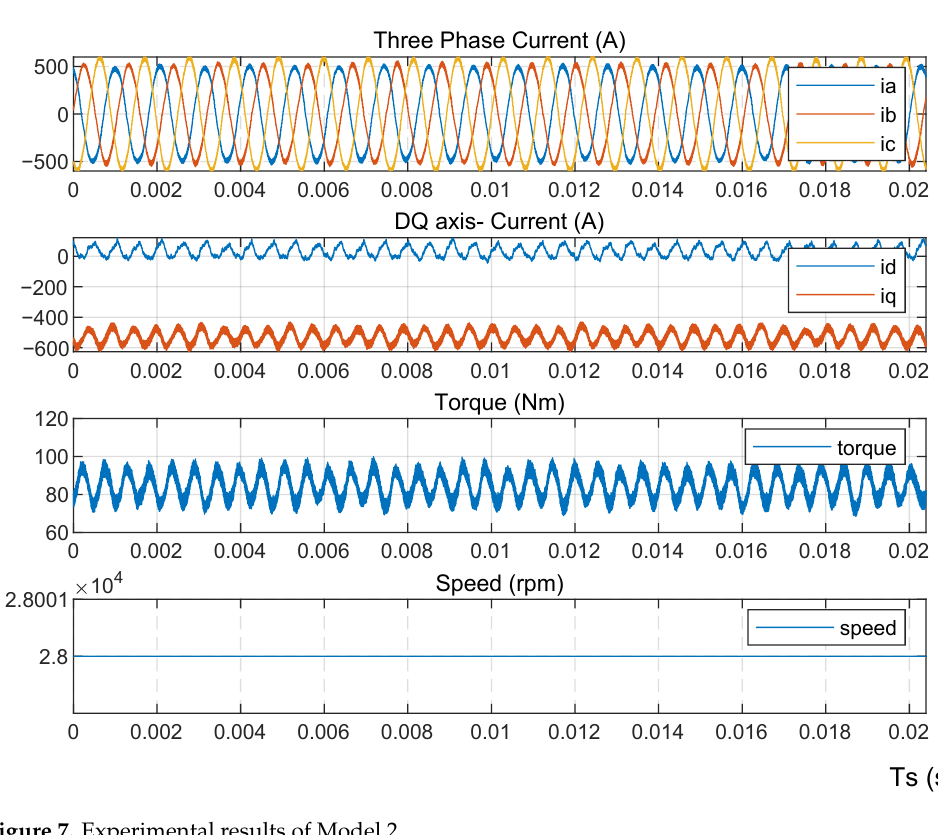
Figure 7. Experimental results of Model 2.